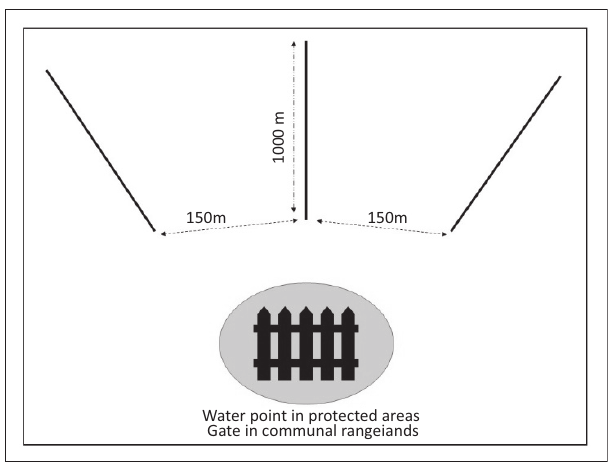
FIGURE 1-A1: Diagram showing layout of three transects at each site. At each site, the three transects were set up within 40 meters from a water point (in protected areas) or a livestock camp gate (in communal rangelands). Transects started 150 meters from one another and radiated out from on another. Transects were 1000 meters in length.